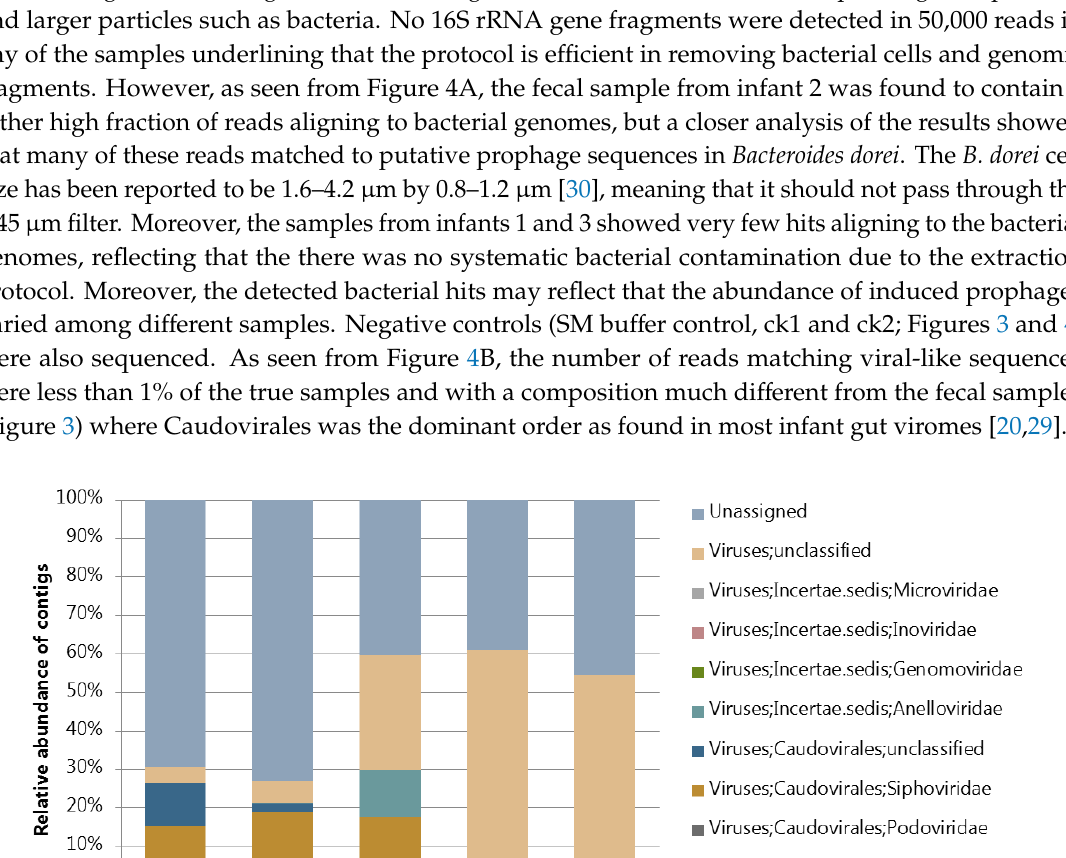
Figure 4. ( A ) Distribution of sequencing reads into the different taxonomic categories viral, human, bacterial, and unknown origin. To check the presence of non-viral DNA sequences, 50,000 random forward reads were evaluated according to their match to a range of viral, bacterial, and human reference genome and protein databases as described in [17]. No reads (in 50,000 reads) matched to the 16S rRNA gene sequences in all the samples. ( B ) Relative abundance of sequencing reads matching the assembled virus-like contigs compared to the average of the three true samples. At least 10 times